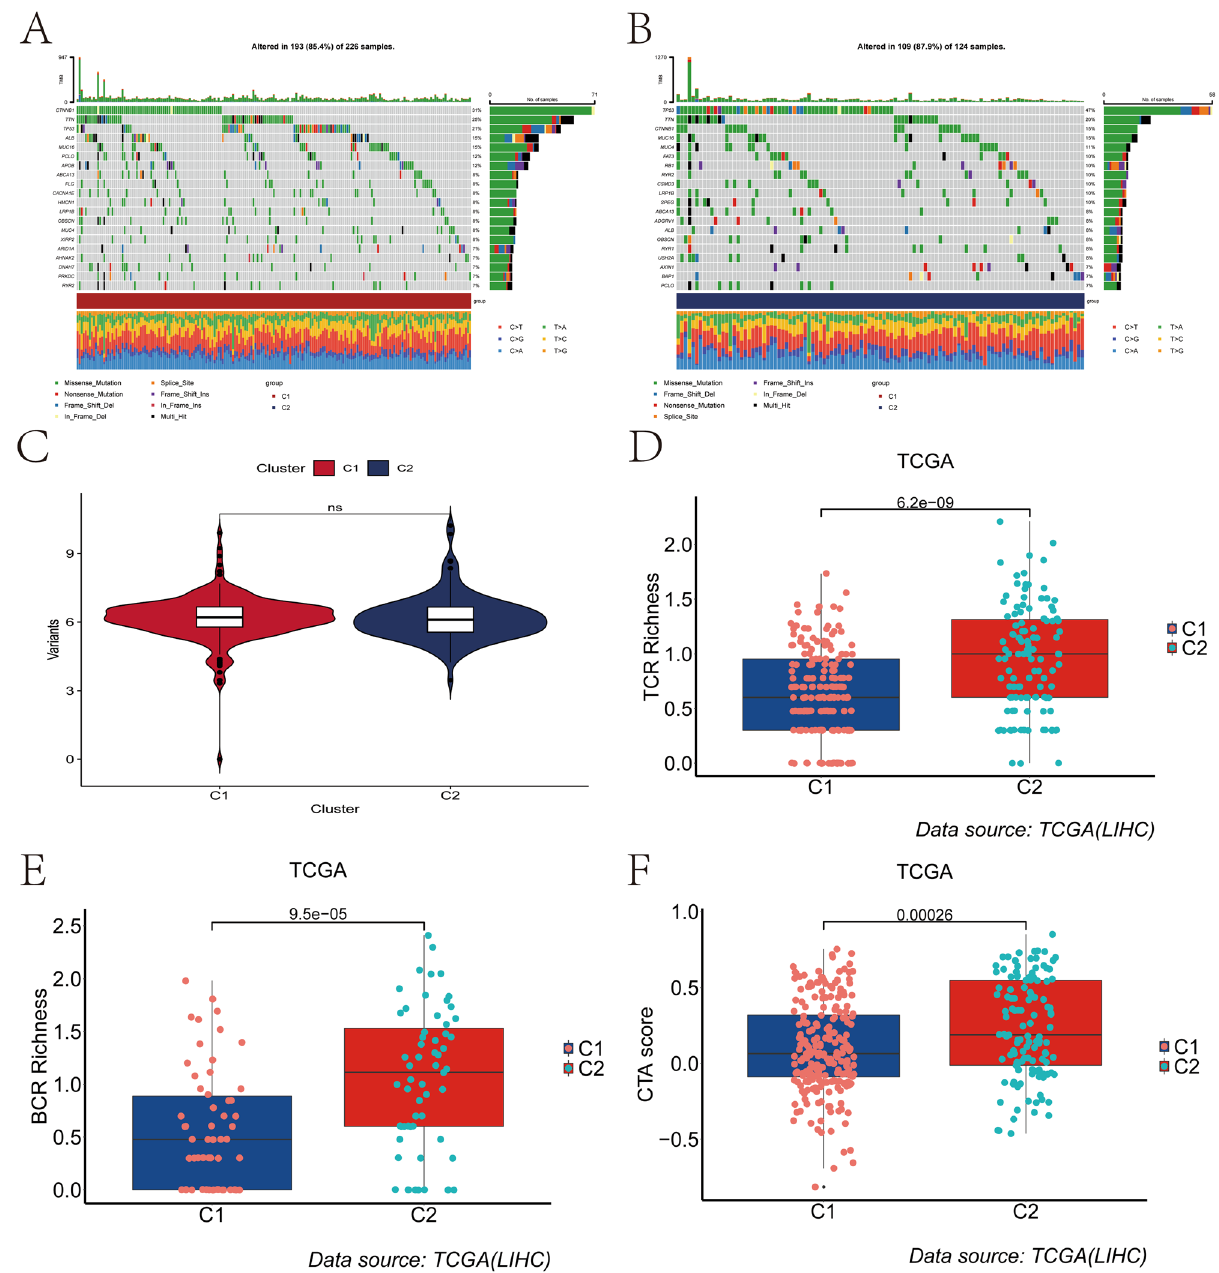
Figure 5. Tumor somatic gene mutation and immunotherapy response prediction. ( A ) Mutation landscape of tumor somatic cells in patients with cluster C1. ( B ) Landscape of tumor somatic cell mutations in patients with C2 clusters. ( C ) Differences in the distribution of tumor mutation burden among clusters. ( D – F ) Differences between different clusters in TCR Richness ( D ), BCR Richness ( E ) and CTA scores ( F